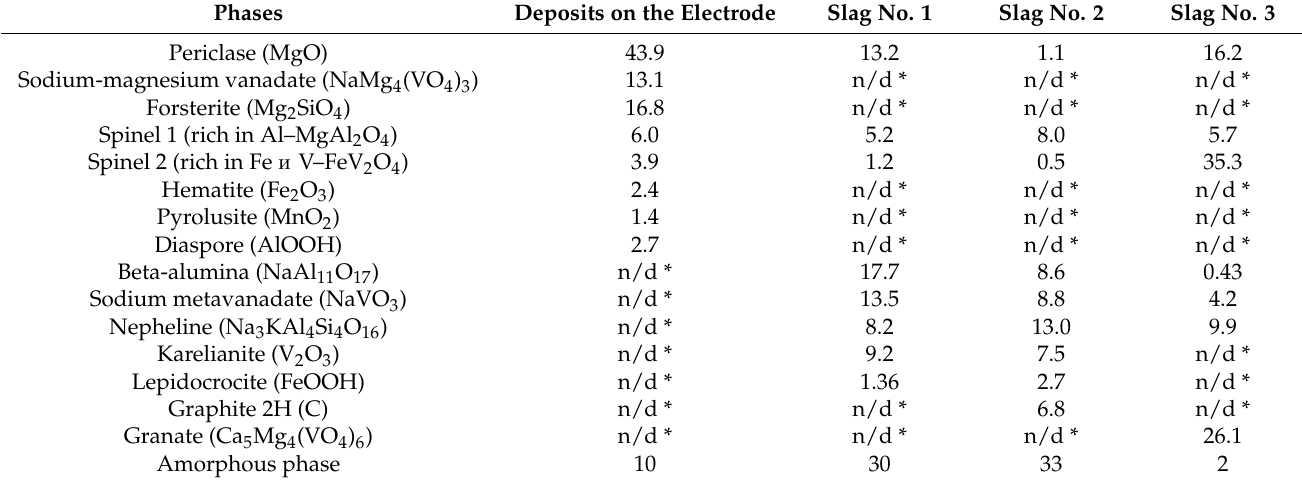
Table 4. The quantitative phase composition of slag and deposits on the electrode,